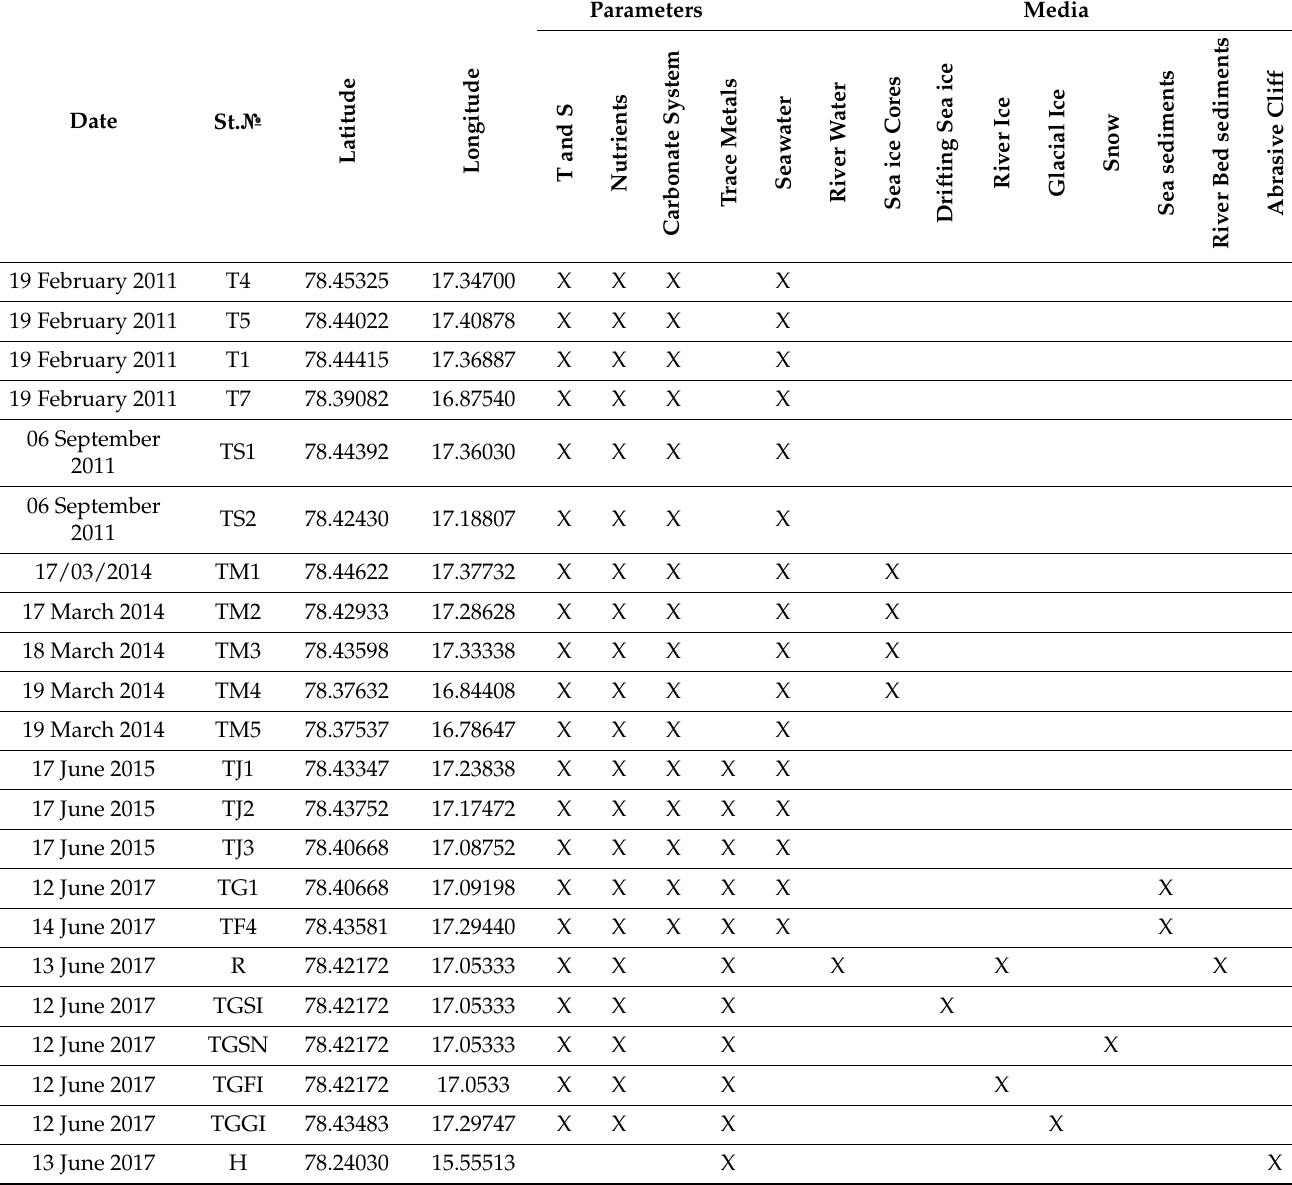
Table A8. The list of stations, locations, studied parameters and environmental media in different expeditions performed in this